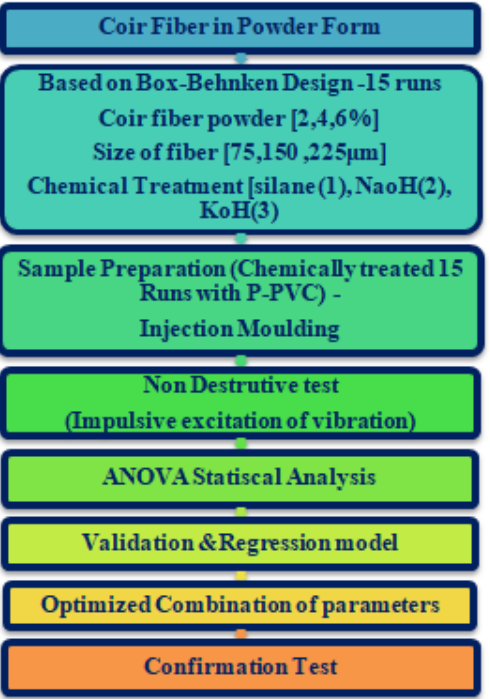
Figure 2. Flowchart for the sample preparation using impulsive excitation of vibration.